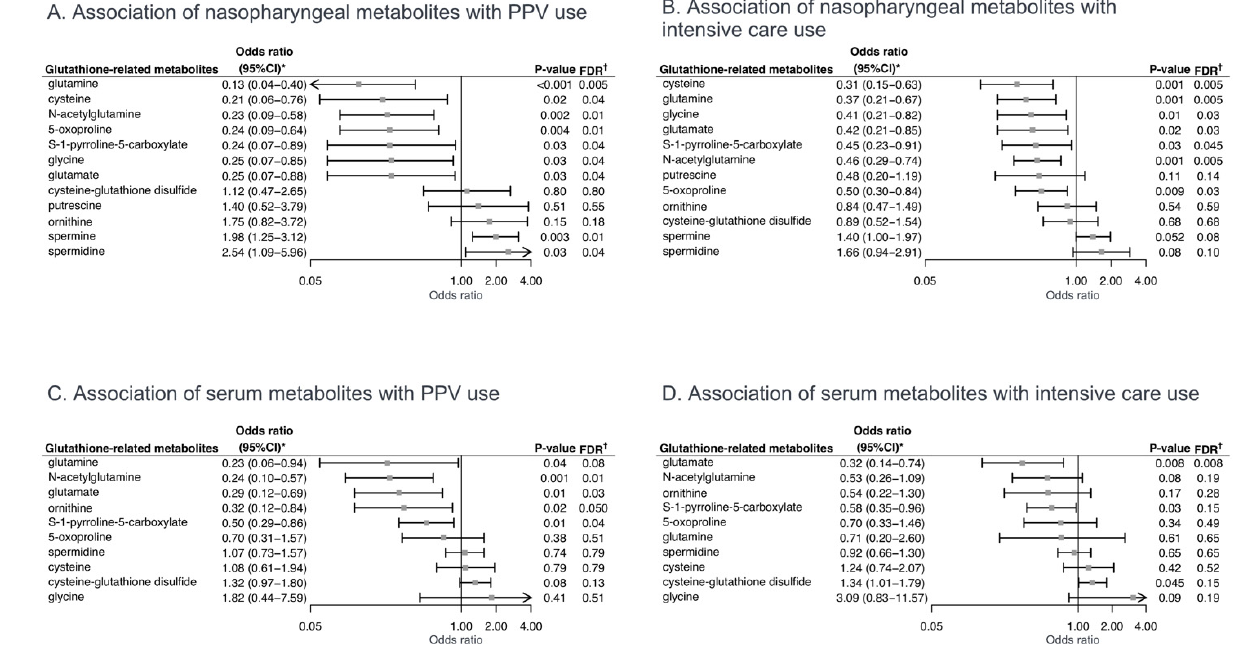
Figure 3. Adjusted associations of nasopharyngeal and serum glutathione-related metabolites with severity outcomes in infants hospitalized for bronchiolitis. ( A ). Multivariable-adjusted asso- ciation of nasopharyngeal glutathione-related metabolites with PPV use. The ORs were estimated for a 1% change in the relative abundance of metabolites. ( B ). Multivariable-adjusted association of nasopharyngeal glutathione-related metabolites with intensive care use. The ORs were estimated for a 1% change in the relative abundance of metabolites. ( C ). Multivariable-adjusted association of serum glutathione-related metabolites with PPV use. The ORs were estimated in a 2-fold change in the abundance of metabolites. ( D ). Multivariable-adjusted association of serum glutathione-related metabolites with intensive care use. The ORs were estimated in a 2-fold change in the abundance of metabolites. Arrows indicate that the 95%CI of the odds ratio exceeds the lower or higher limit of the x -axis. * Estimated by fitting logistic regression model adjusting for potential confounders (age, sex, and RSV infection). † The Benjamini–Hochberg FDR method was used to account for multiple testing. Abbreviations: CI, confidence interval; FDR, false discovery rate; OR, odds ratio; PPV, positive pressure ventilation; RSV, respiratory syncytial virus.